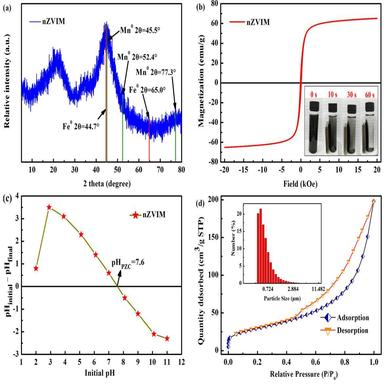
(a) The XRD pattern; (b) magnetization profiles, the inset image is the magnetic separation demonstration from time zero to 60 s; (c) point of zero charge; (d) BET analysis of the as-prepared nZVIM based on the N2 gas sorption-desorption, the inset is the size distribution of nZVIM.